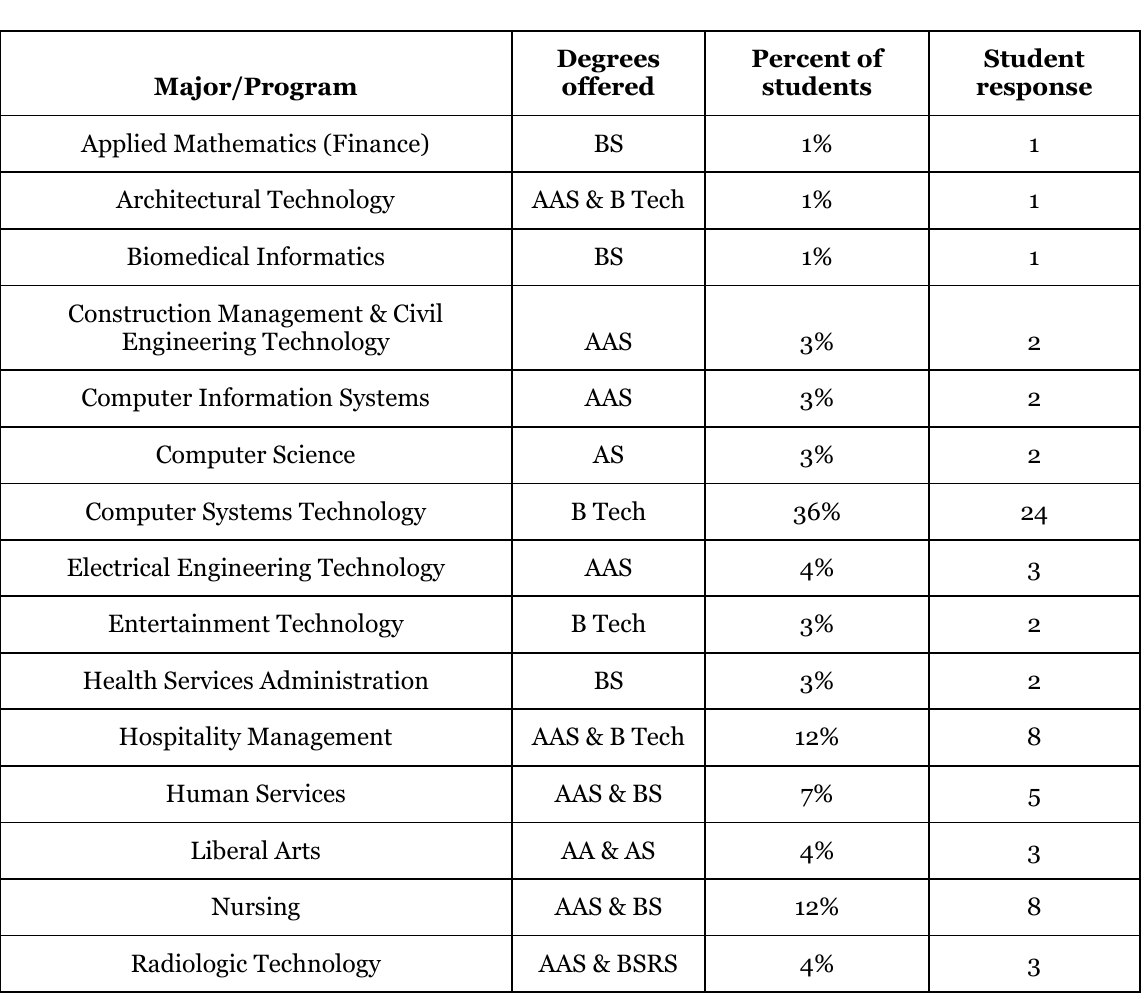
Table 1 Distribution of Student Majors